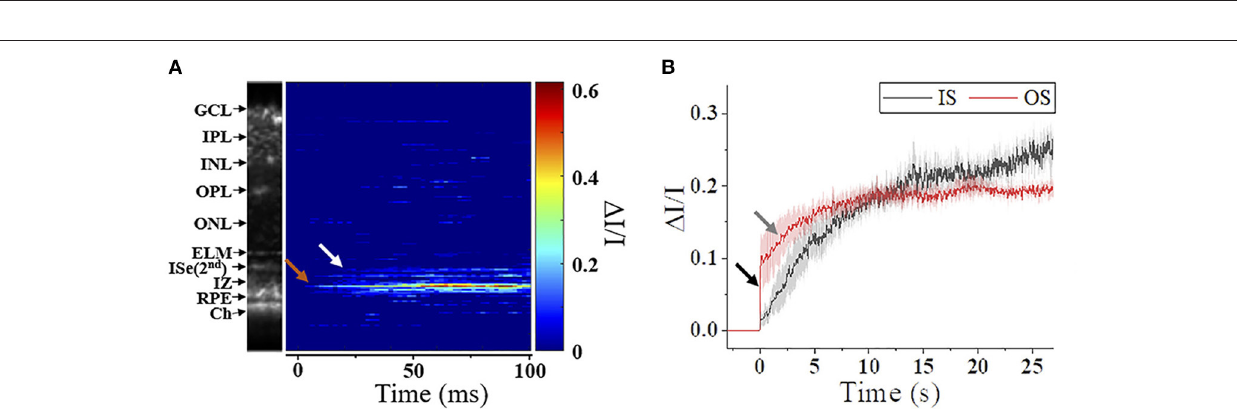
FIGURE 8 | Metabolic response of photoreceptor inner segment. (A) IOS M-scan within 100ms, the white and red arrowheads show the onsets of IS-IOS and OS-IOS, respectively. (B) Average IS-IOS and OS-IOS from six mice. The average OS-IOS showed a biphasic curve. The dark and gray arrowheads show the first rapidly increasing phase and the second gradually increasing phase, respectively. GCL, ganglion cell layer; IPL, inner plexiform layer; INL, inner nuclear layer; OPL, outer plexiform layer; ONL, outer nuclear layer; ELM, external limiting membrane; ISe, inner segment ellipsoid; IZ, interdigitation zone; RPE, retinal pigment epithelium; Ch, Choroid; IS, photoreceptor inner segment; OS, photoreceptor outer segment. Reprinted with permission from Ma et al. (